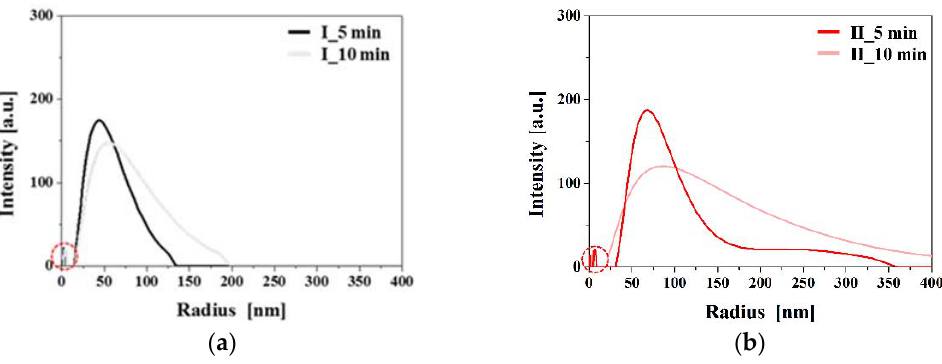
Figure 9. Dynamic light spectroscopy (DLS) measurement of synthesis Ag NPs ( a ) case I and ( b ) case II.